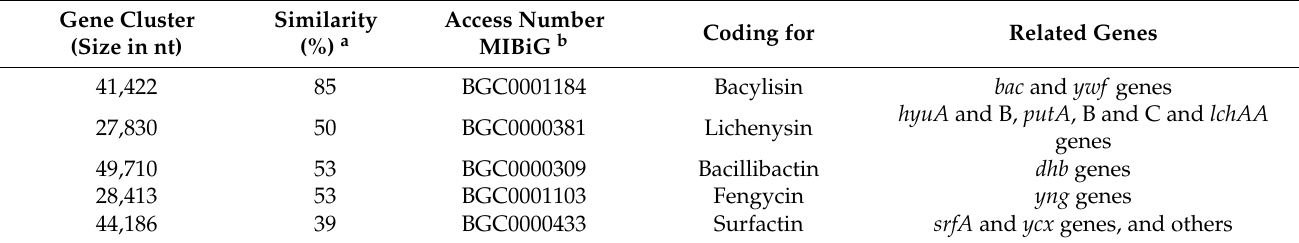
Table 2. Biosynthetic gene clusters related to the production of a variety of antimicrobial substances in the Bacillus safensis T052-76